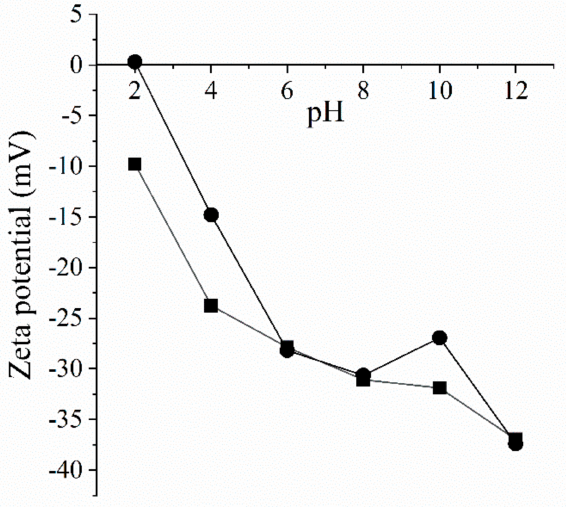
Figure 6. Zeta potential measurements as a function of pH for CLI (square) and MAG-CLI